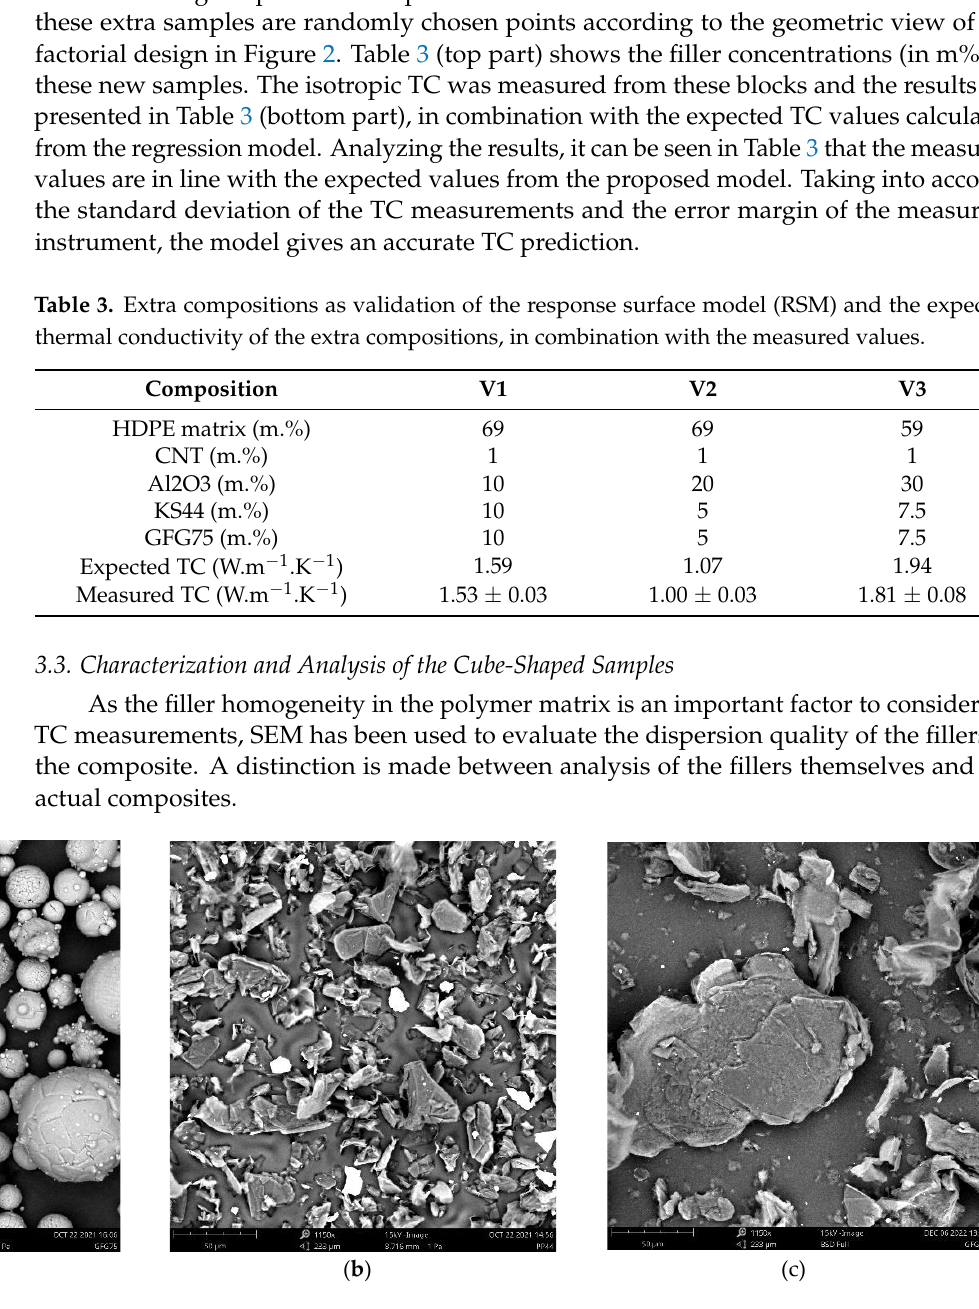
Figure 4. SEM images of the fillers: ( a ) Aluminum oxide (Al 2 O 3 ); ( b ) Graphite (G); ( c ) Expanded Graphite (EG).